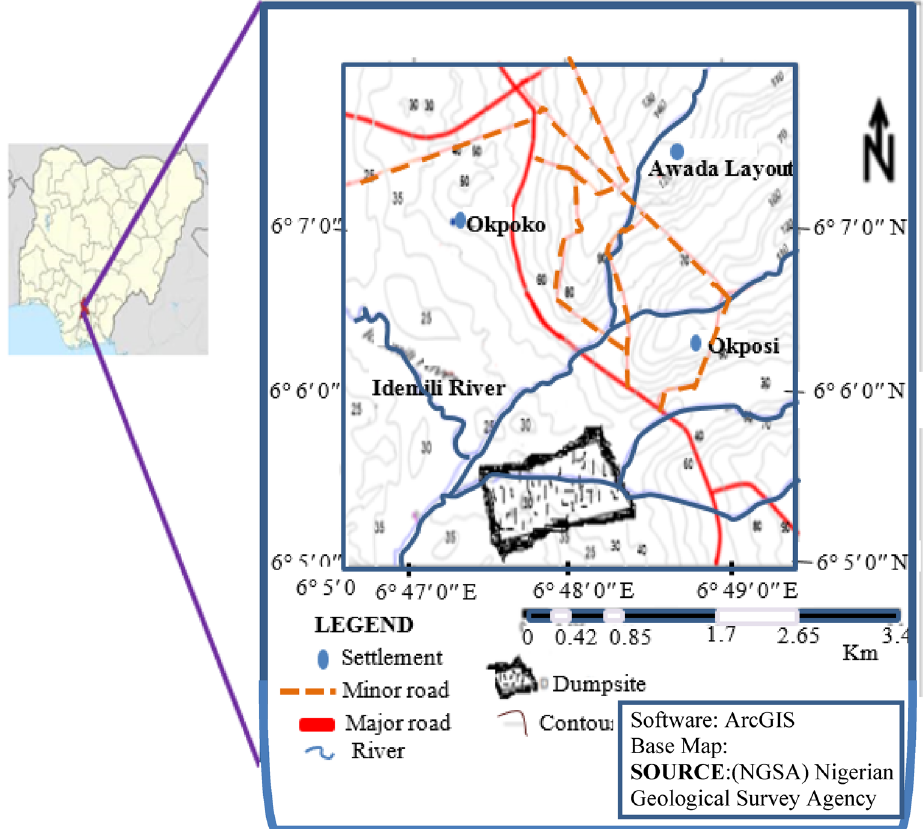
Figure 2. Location map of the study area produced from the field data and the topographic map showing the location of the dumpsite and the accessibility, drainage, and topography. (ArcGIS info: https:// esri. uconn. edu/ softw are/ arcgis- stude nt/ downl oad/. https:// link. sprin ger. com/ refer encew orken try/ 10. 1007% 2F978-0- 387- 35973-1_